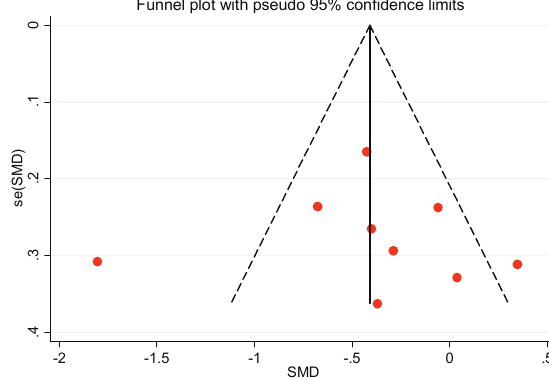
Funnel plot with pseudo 95% confidence